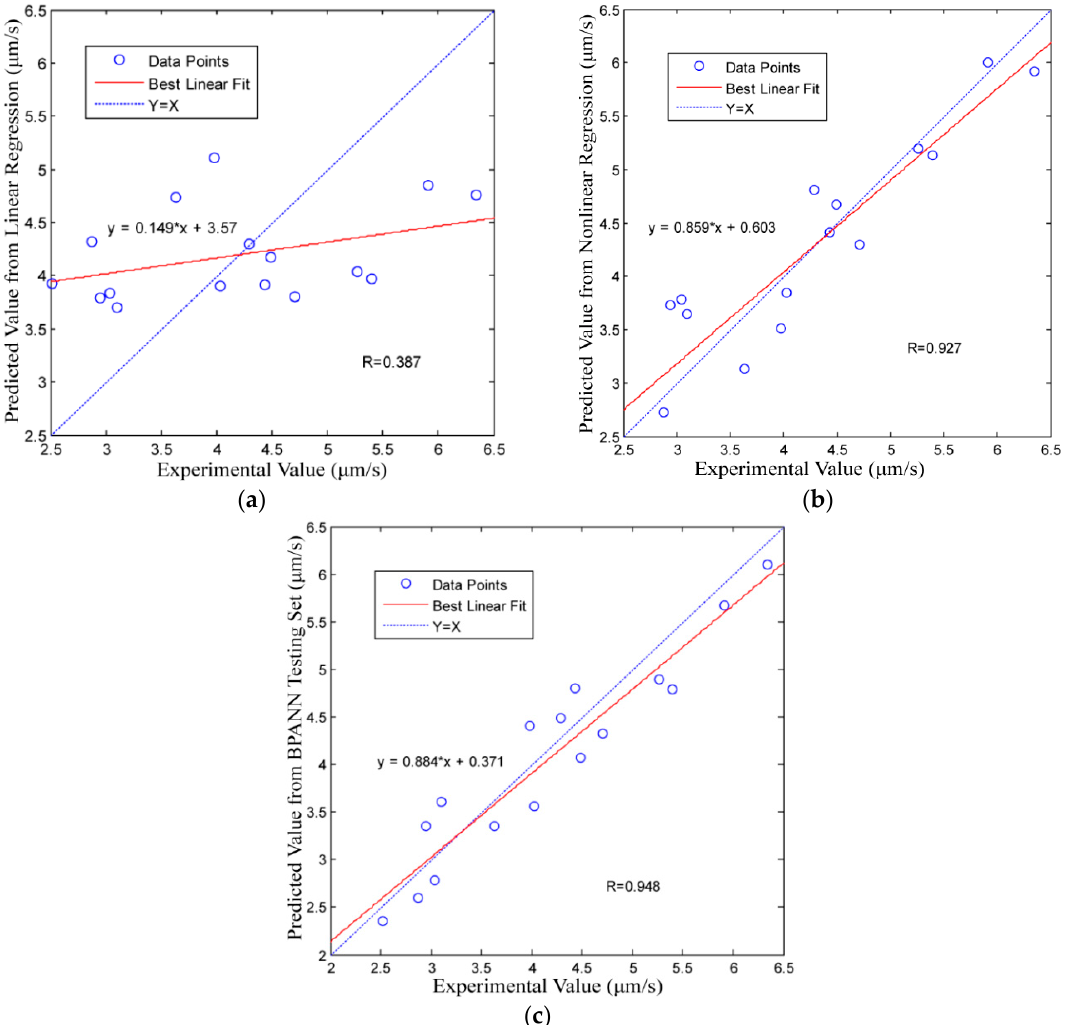
Figure 2. Correlation between the predicted values and the experimental values along with the best linear fit to the data: ( a ) the conventional linear regression model; ( b ) the improved nonlinear regression model; and ( c ) the BPANN model.